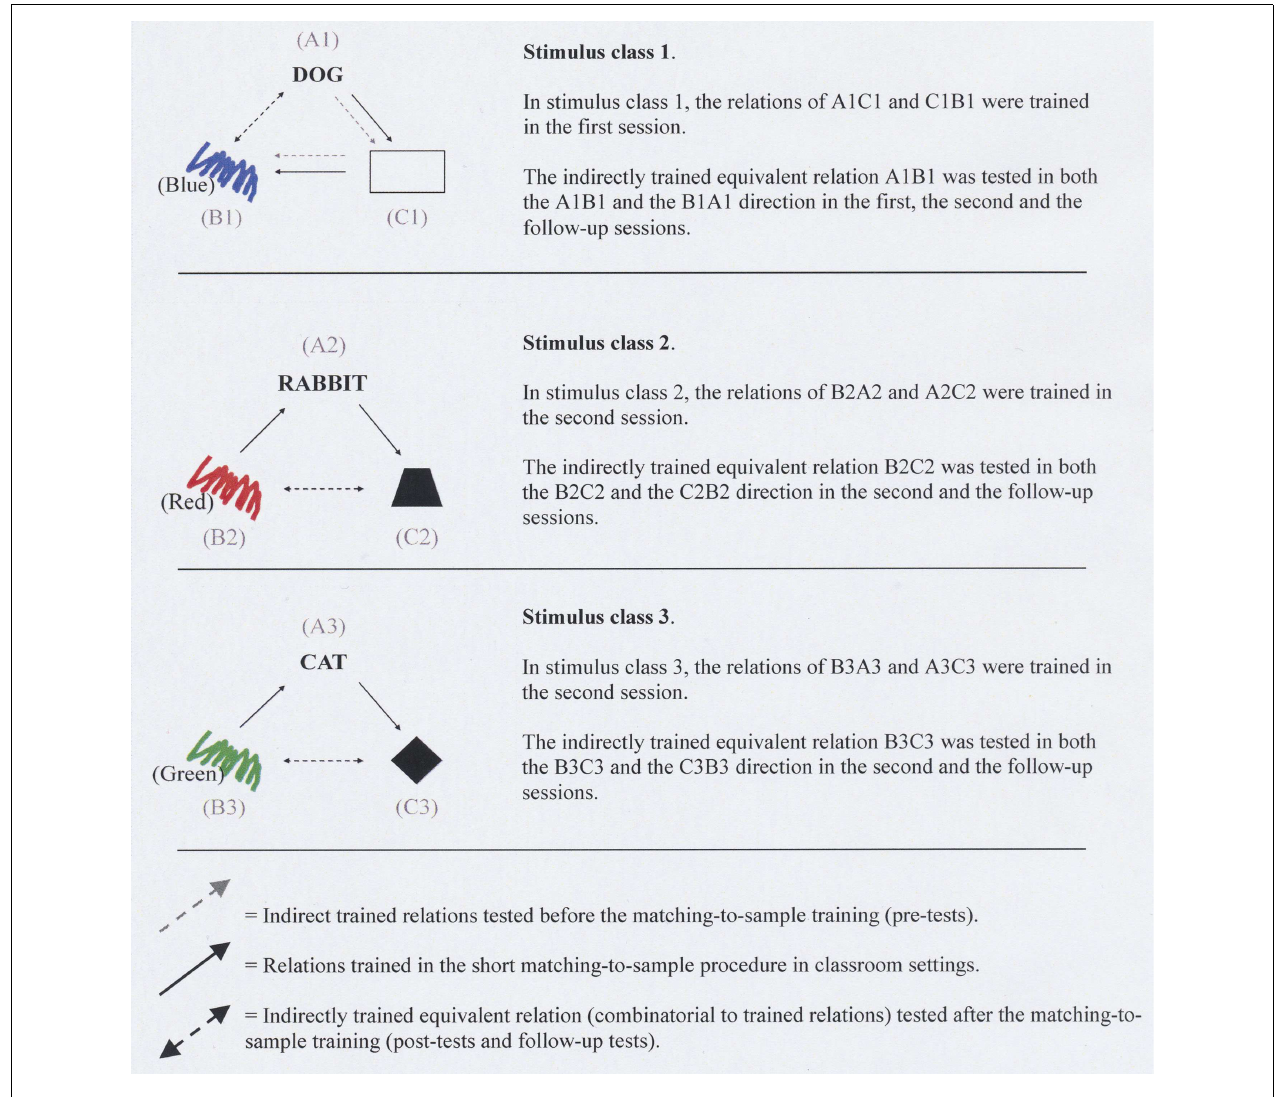
FIGURE 1 |The three stimulus classes (1, 2, and 3) and the stimulus relations that had been pre-tested, trained, post-tested before the current study. The words (Blue), (Red), (Green), in the trial examples illustrated, were not visible to the students.The same applies to Figure 2 . From Billinger and Norlander (2011), Copyright (2011) by Billinger and Norlander. Reprinted by